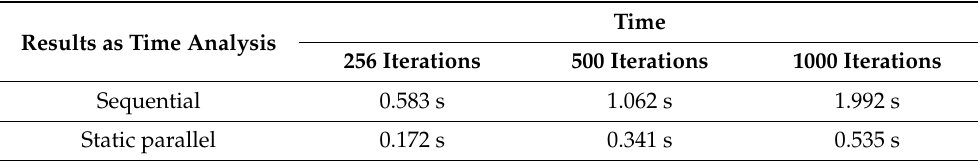
Table 1. Table with the difference in execution times between the classic sequential implementations and the parallel implementations proposed in the paper. Time Results as Time Analysis 256